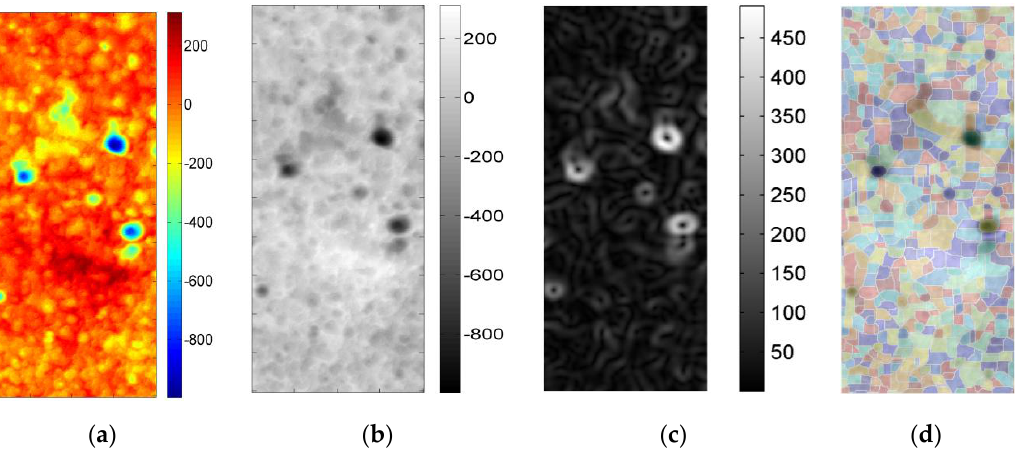
Figure 4. Identification process of rust pits based on watershed algorithm: ( a ) topography matrix T , ( b ) gray matrix I , ( c ) gradient matrix B , ( d ) mark matrix L .